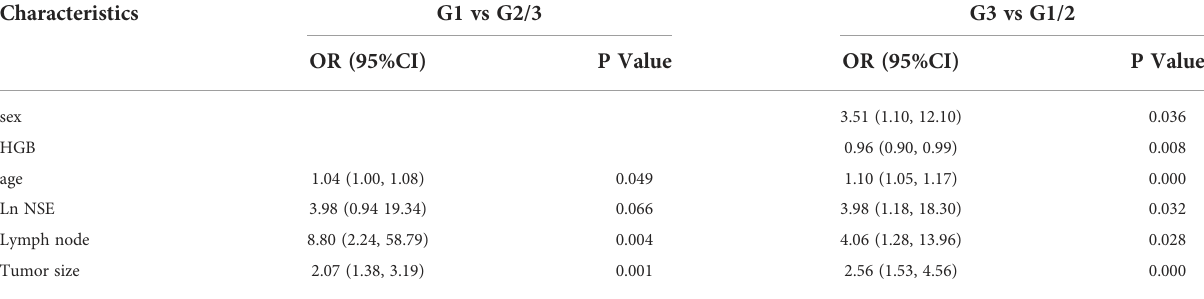
TABLE 3 Multivariable Logistic Regression Model for Predicting G3 vs G1/2 and G1 vs G2/3. Characteristics